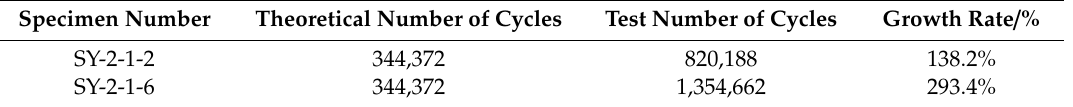
Table 7. The comparison between theoretical number of cycles and test number of cycles.